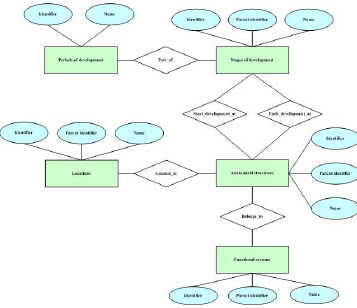
Figure 3: The entity-relationship diagram illustrates the logical structure of the DAOZ